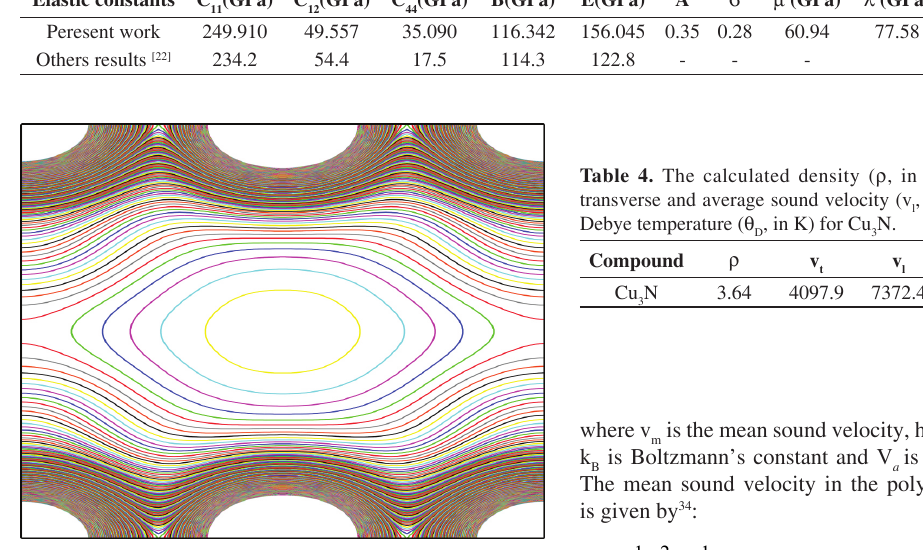
Table 3. The elastic constants of Cu